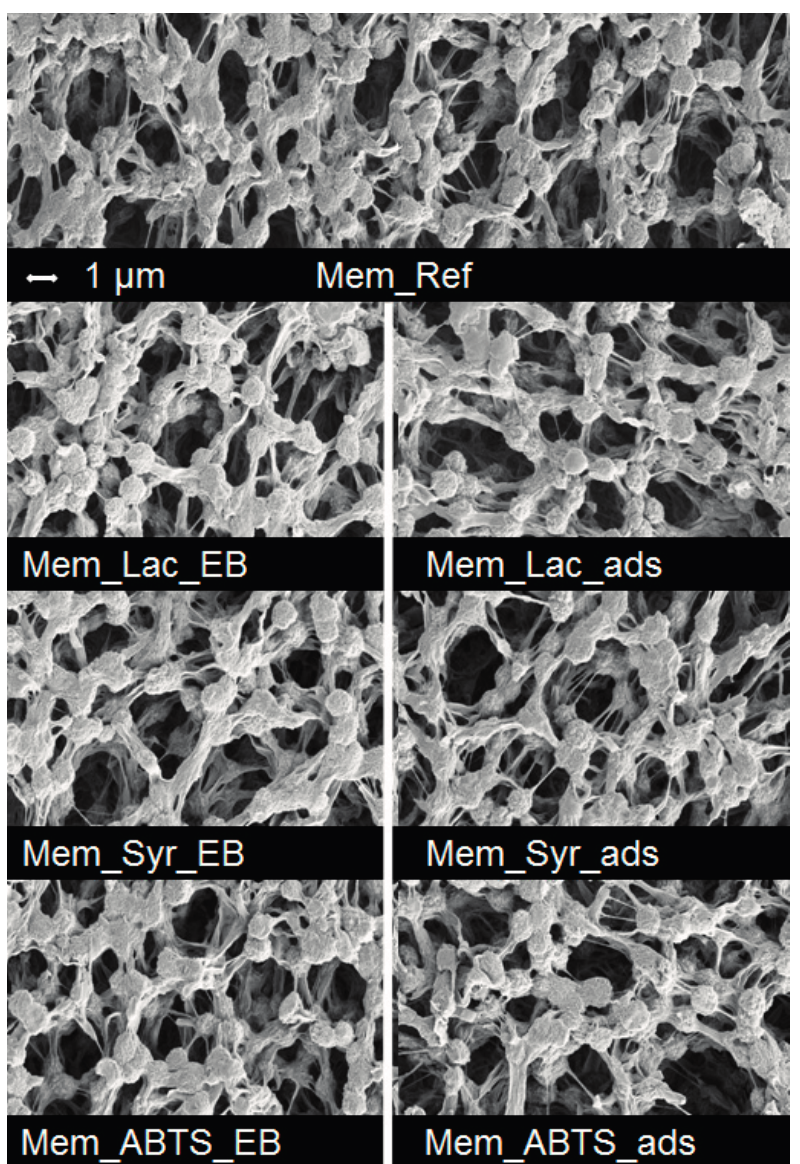
This E-Beam immobilization method was compared with a common used physical adsorption immobilization method (coating without E-Beam) at the membrane surface. Figure 3. SEM images of the untreated reference membrane and of the membranes after immobilization of laccase, Syr, and ABTS using E-Beam treatment and by physical